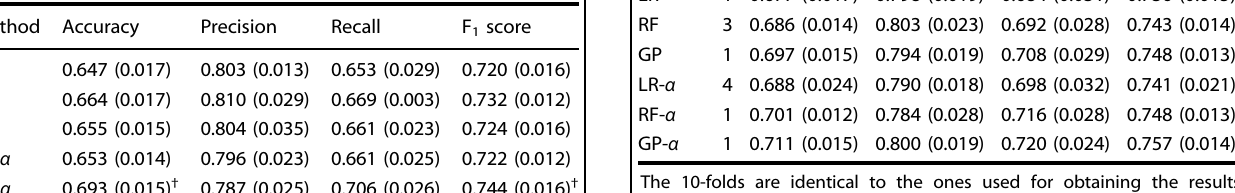
Table 2. Classi fi cation accuracy estimates with their standard deviation (in parentheses) for predicting student response (full response versus otherwise) obtained via a 10-fold cross-validation for the following methods: logistic regression with elastic net regularisation (LR), random forest (RF), Gaussian process (GP), and the same models under an expanded feature set considering student attributes ( ⋆ - α ).